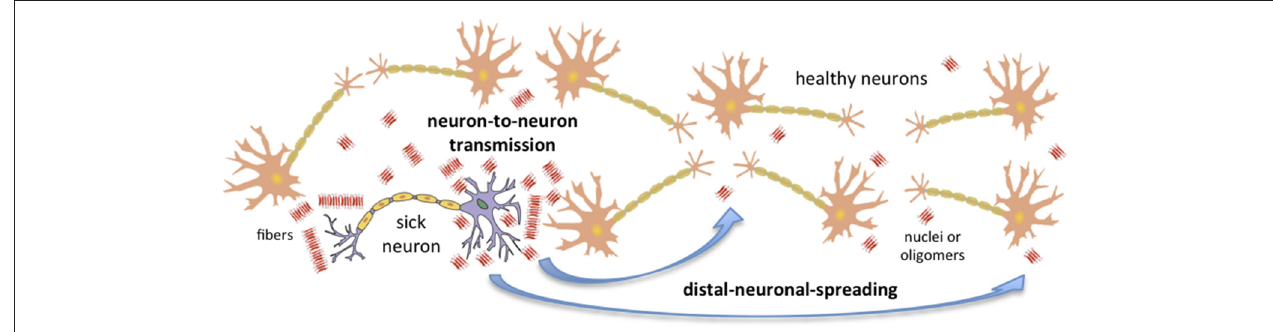
FIGURE 1 | Amyloid transmission mechanisms. Amyloid aggregates could be transmitted from a sick neuron to healthy neurons via two main mechanisms: neuron-to-neuron transmission and distal neuronal spreading. The concentration of nuclei, the presence of oligomers, and the toxicity, resistance and localization of these aggregates are key factors affecting putative neuronal invasion. Note that in order to simplify the figure, only neurons have been considered; nonetheless, it is important to take into account that astrocytes and other cells can also sporadically generate aggregates.